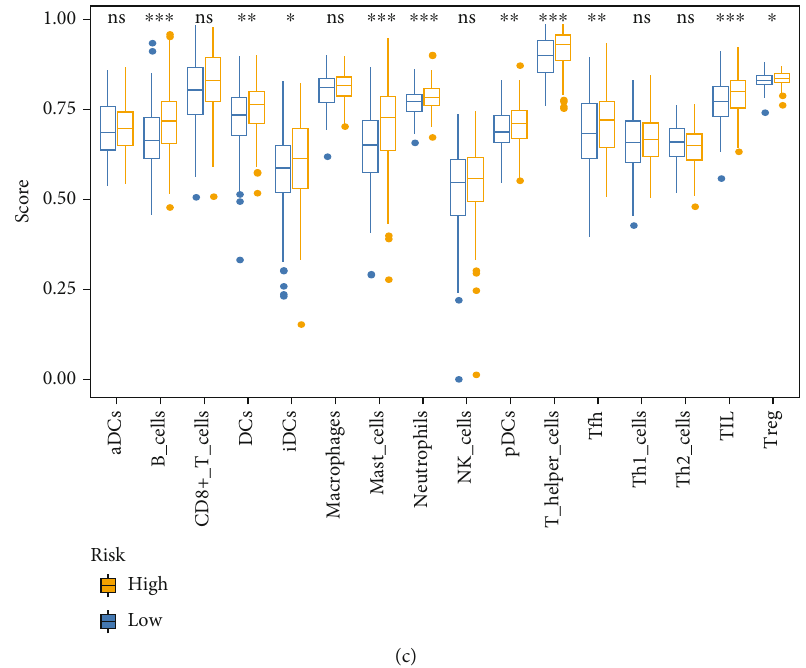
Figure 8: Immune landscape in the high- and low-risk groups. (a) Correlation analysis between the GIMiSig and various intratumor cell subpopulations. (b) Evaluation of immune landscape in the high- and low-risk groups based on ESTIMATE. (c) Boxplots showing distribution of immune cells in the high- and low-risk groups using the ssGSEA algorithm. Yellow indicates the high-risk group, and blue indicates the low-risk group. ∗ p < 0 : 05 , ∗∗ p < 0 : 01 , and ∗∗∗ p < 0 : 001